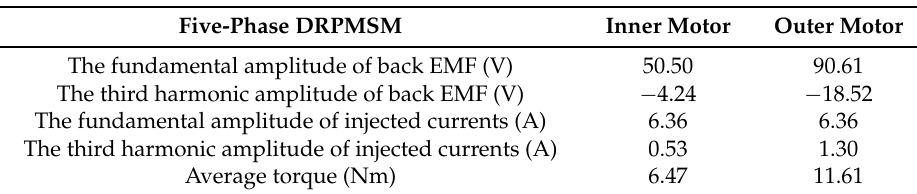
Table 5. The details of the back-EMF and the injected currents when the motor operates at a speed of 1200 rpm at no load in parallel drive mode. DRPMSM: dual-rotor permanent magnet synchronous motor; Electromotive force: EMF.